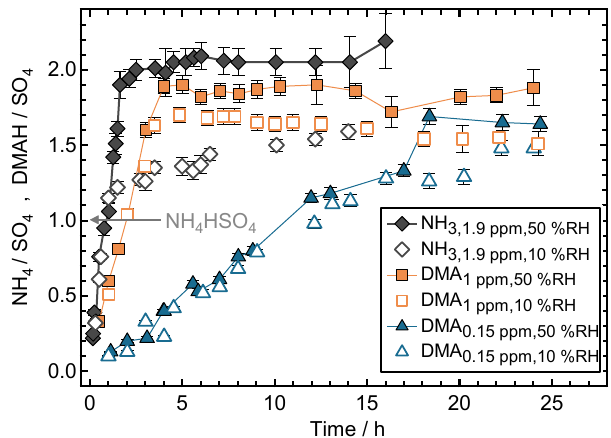
Figure 1. Single-gas uptake of NH 3 (1.9ppm) and DMA (1 and 0.15ppm) into H 2 SO 4 , at 10 and 50% RH. NH 4 / SO 4 and DMAH / SO 4 denote molar ratios of NH 3 or DMA species to total sulfate species in the